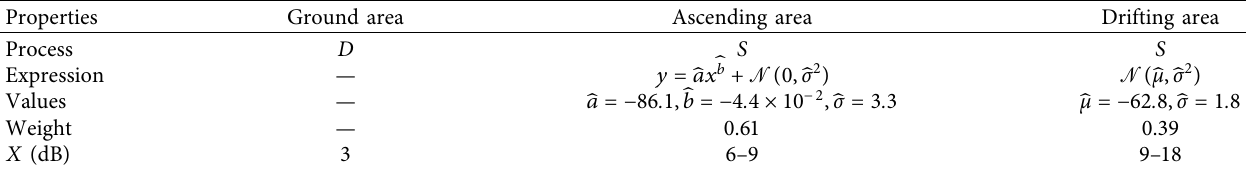
Table 5: A summary of the joint quasi-AoAs and delay